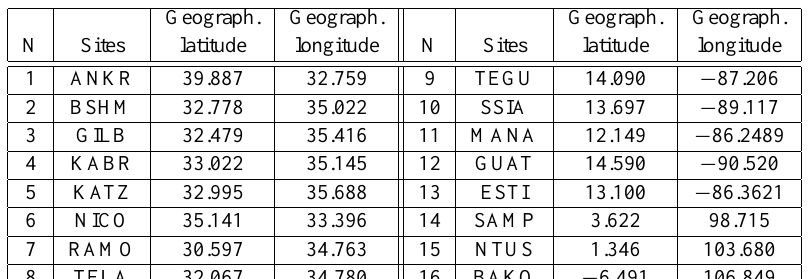
Table 2. GPS-sites and location